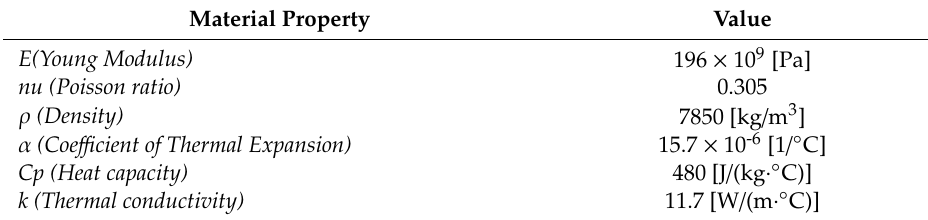
Table 5. Thermo-physical and thermomechanical properties of steel AISI